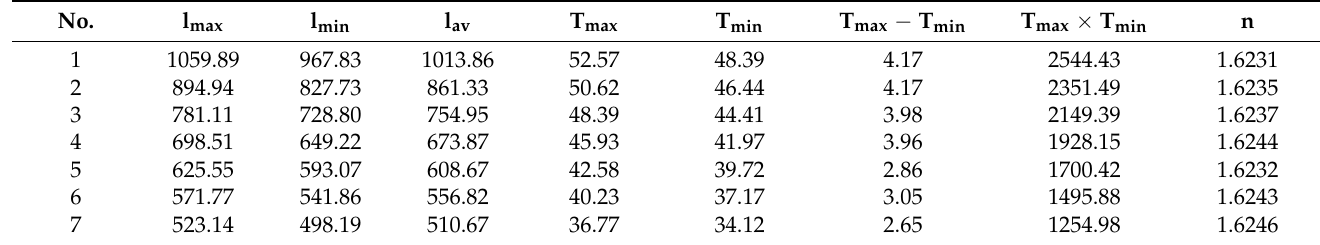
Table 2. Data for calculation of the refractive index from the transmission spectrum.